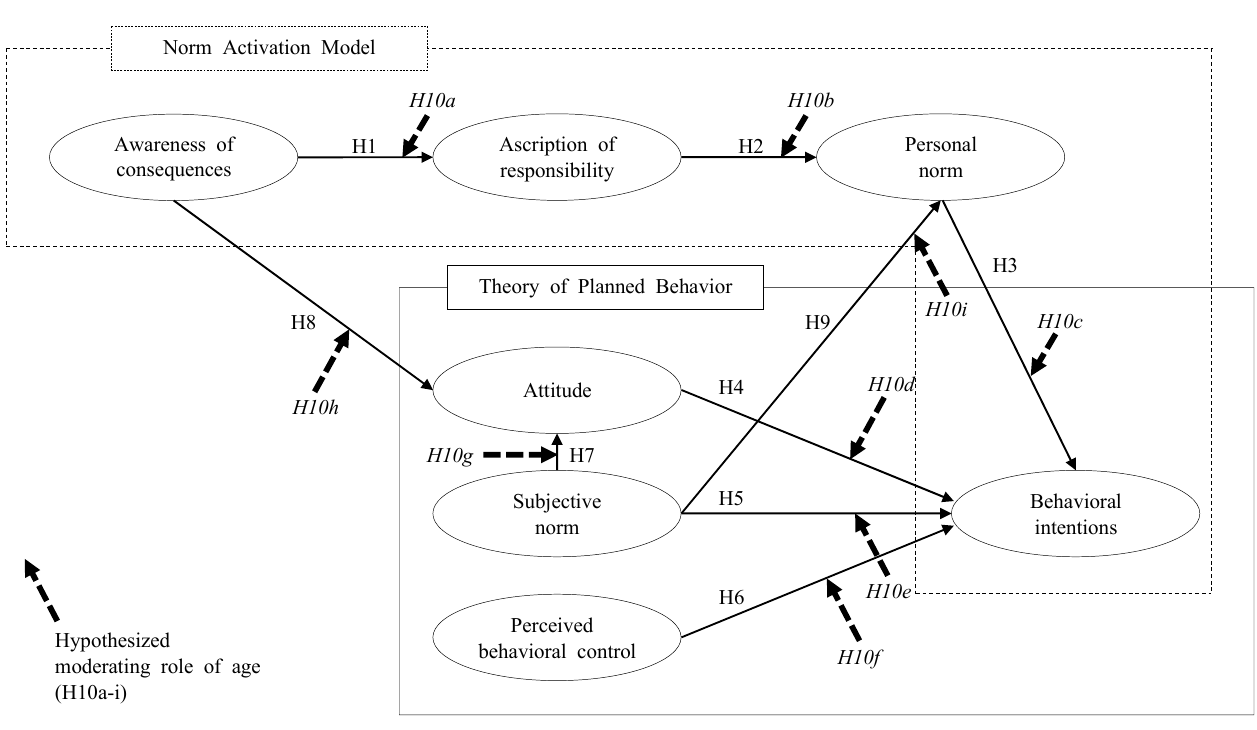
Figure 1. Proposed conceptual model. Note: H = hypothesis.